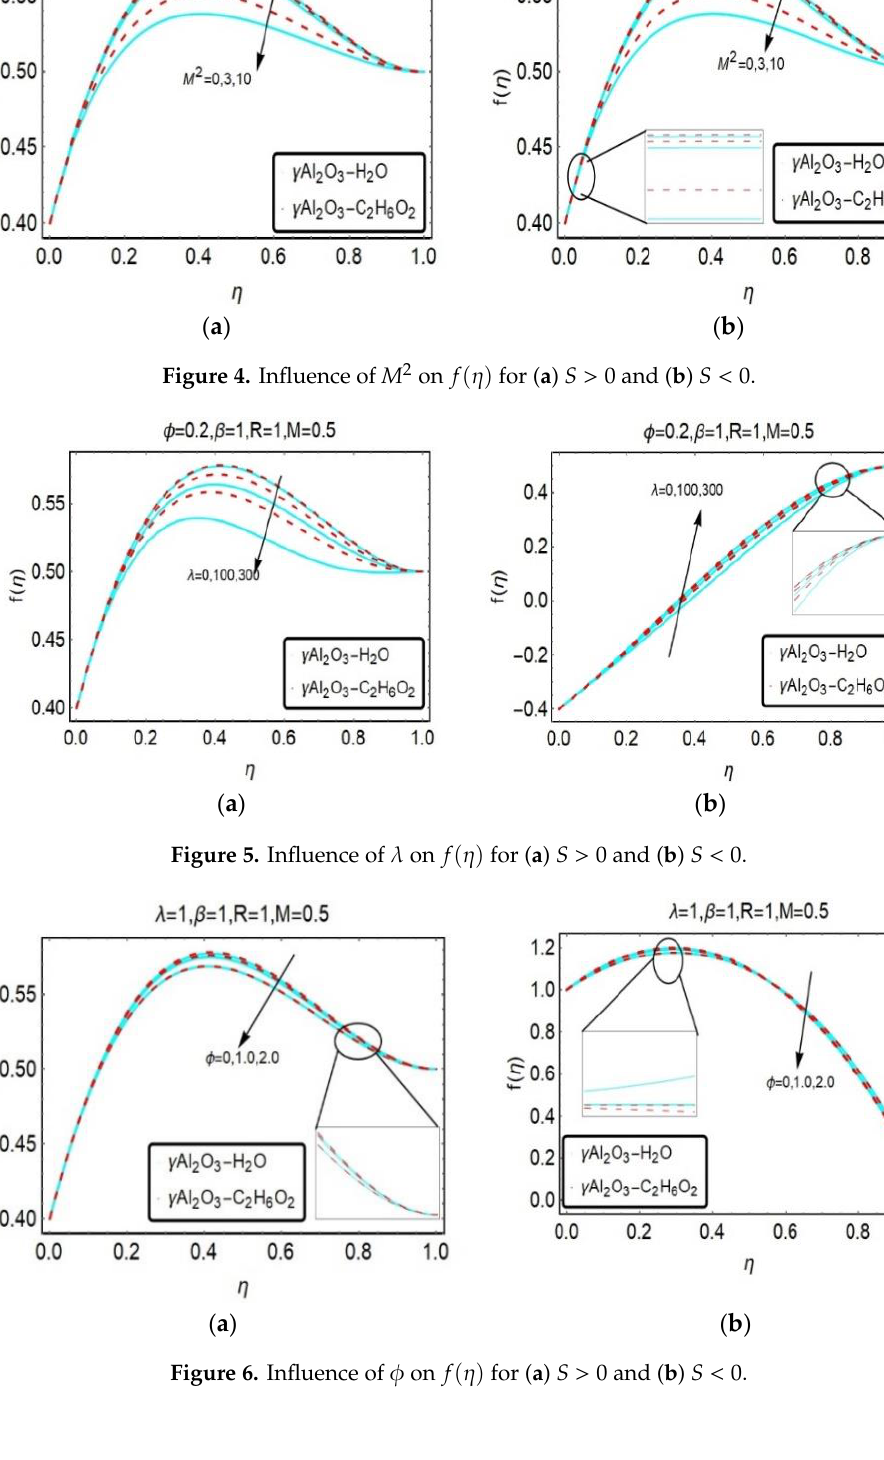
Figure 6. Influence of 𝜙 on 𝑓(𝜂) for ( a ) 𝑆 > 0 and ( b ) 𝑆 < 0 .